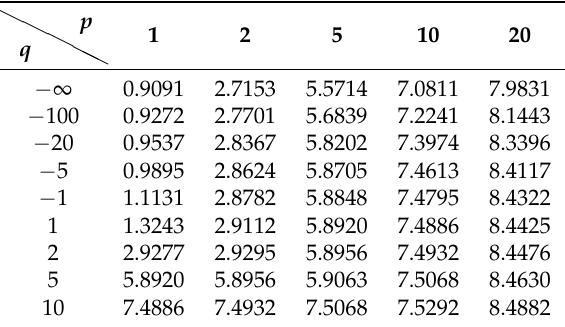
Table 1. ∆ p , q ( P (cid:48) , X 1 ) for several values of p and q .